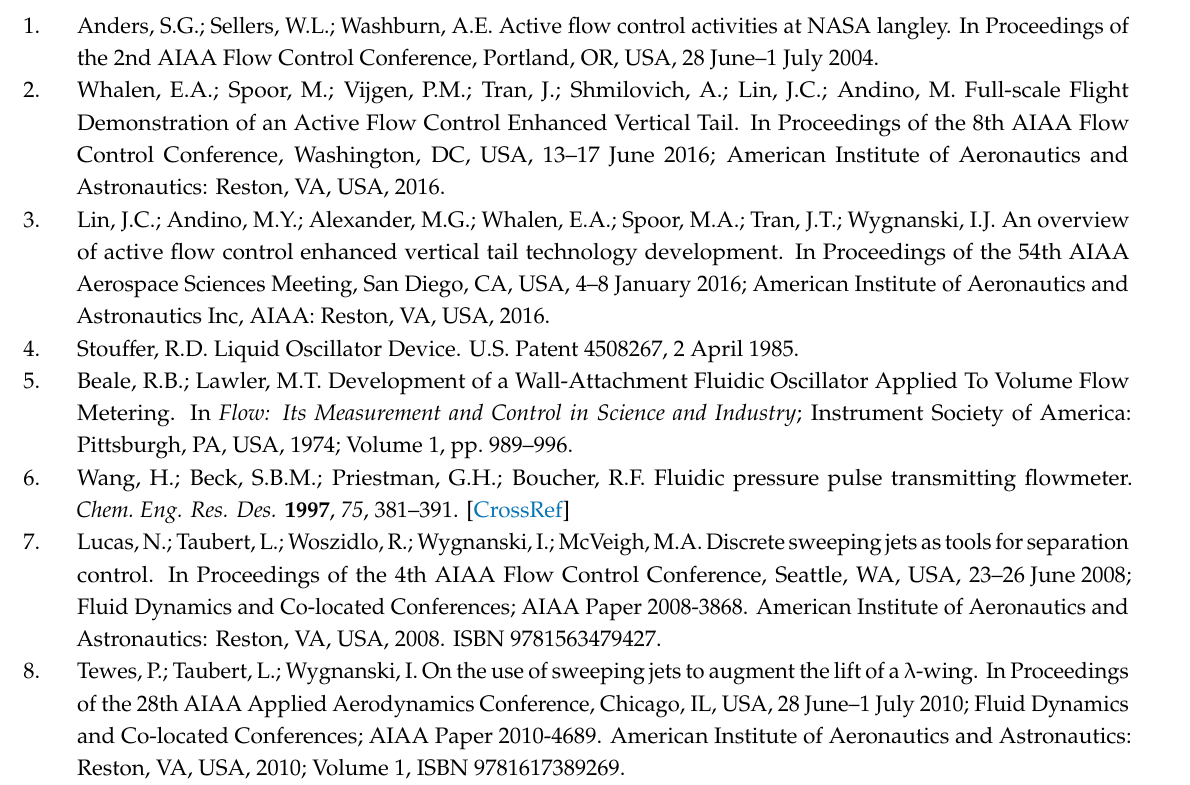
Figure S1: Sketch of the Sweeping Jet Actuator, File S1: SolidWorks model of the Sweeping Jet